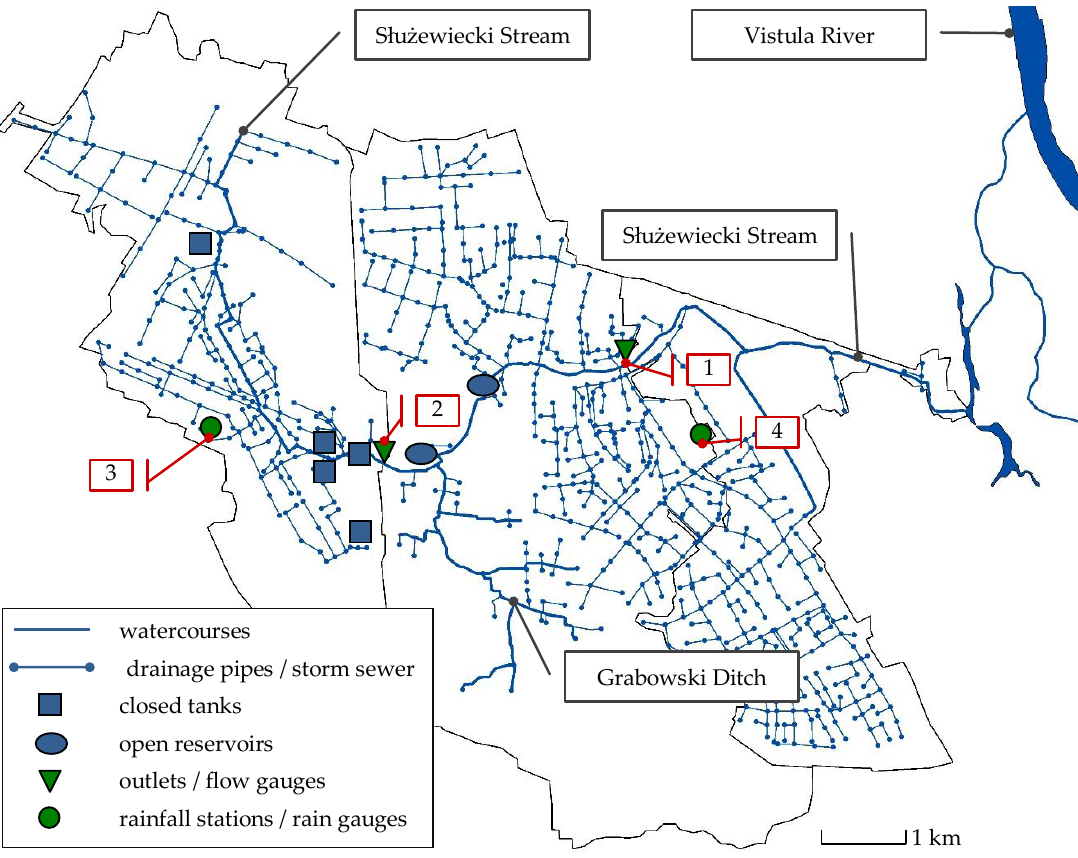
Figure 1. Drainage and measuring system of the Słu˙zewiecki Stream catchment in Warsaw; cross-sections (outlet-profiles) and rainfall stations: (1) Rosoła, (2) Kłobucka, (3) Ok˛ecie, (4) Ursyn ó w. The area of the subcatchment for the Kłobucka cross-section is 16.5 km 2 , with a share of effective impermeable surfaces (hydraulically connected with storm sewers) equal to approx. 23%. Warsaw Chopin Airport, from which rainwaters are directed to the Słu˙zewiecki Stream by a storm water drainage system, occupies the vast majority of the area of this catchment. The Słu˙zewiecki Stream, in the segment from its source to the Kłobucka cross-section (6.5 km in length), is closed along almost the entire length. In the area on the transformation of flows in the